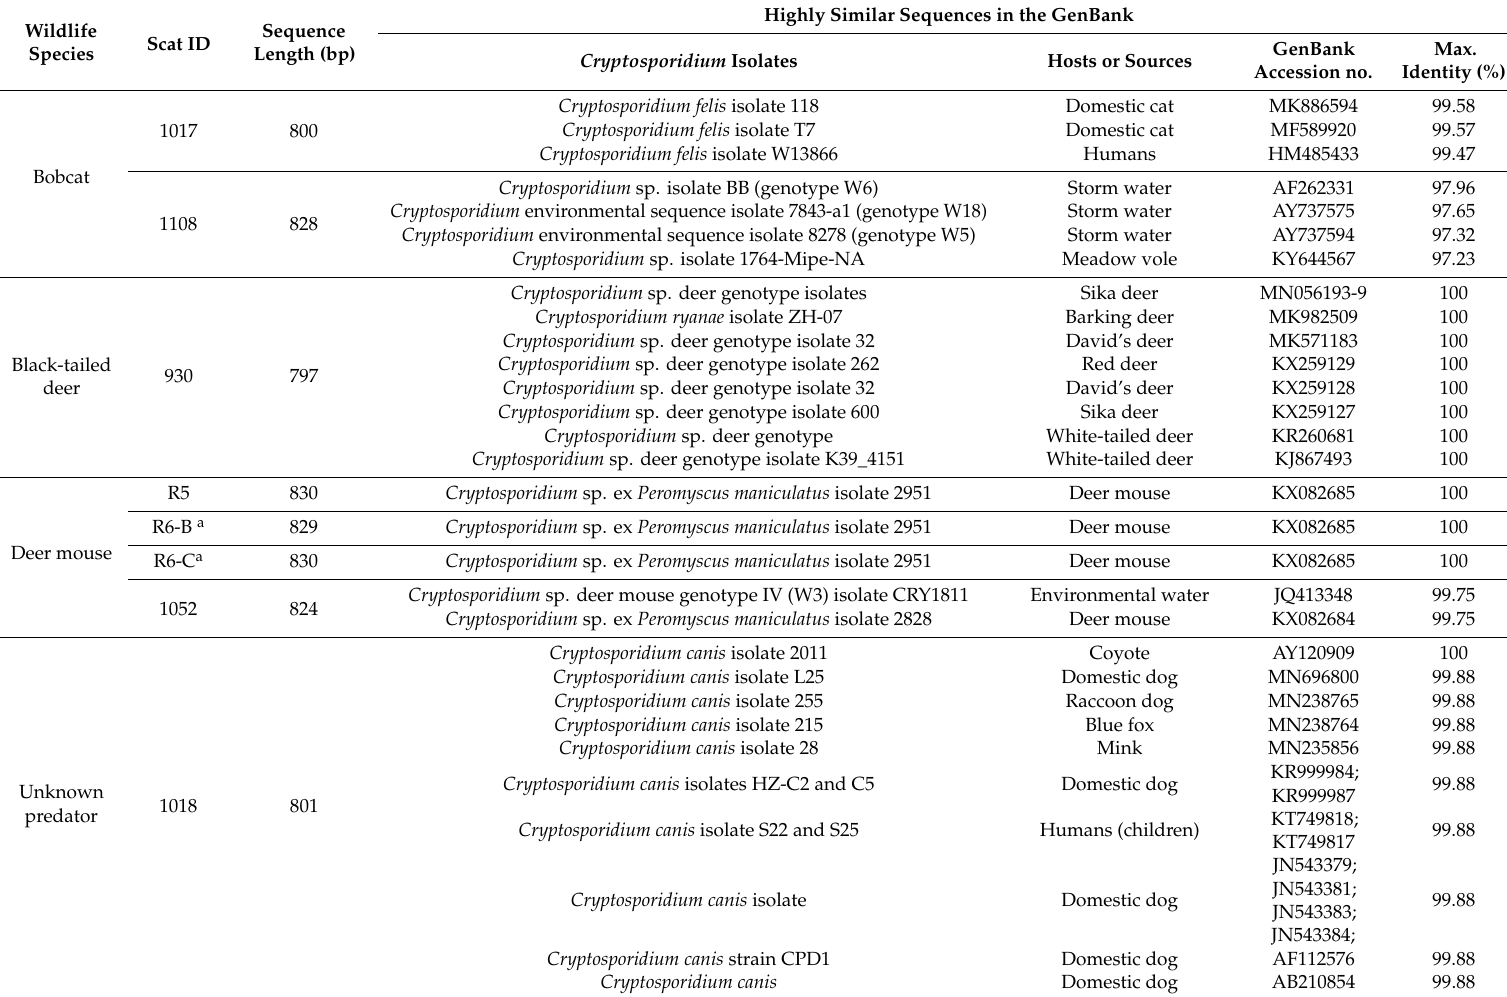
Table 3. Comparison of the 18S rRNA gene sequences of Cryptosporidium from wildlife co-located on a protected watershed in the Pacific Northwest to sequences of Cryptosporidium in the GenBank by BLAST analysis (updated by 12 March,